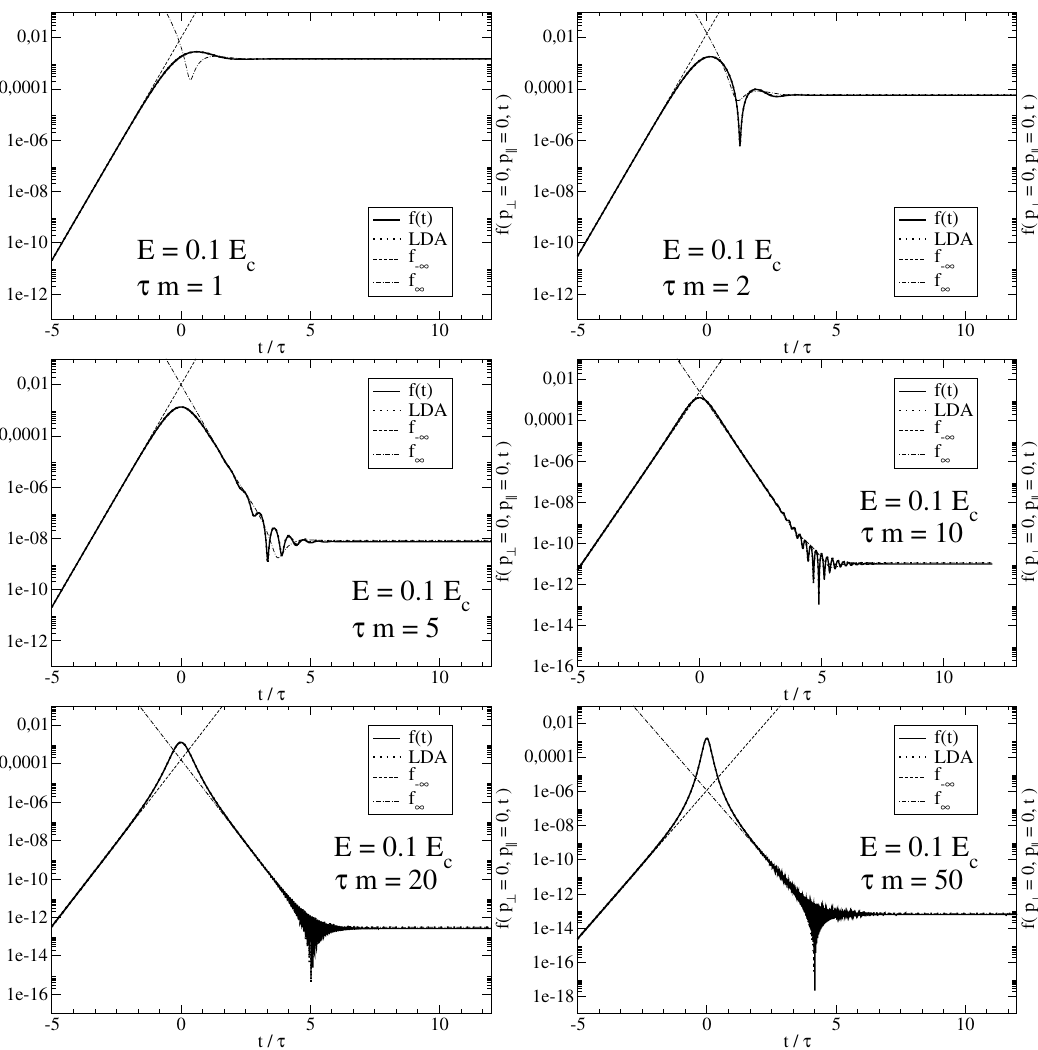
Figure 2. Time evolution of the fermionic distribution function f ( p ⊥ = 0, p (cid:107) = 0, t ) in the case of Sauter pulse for E 0 = 0.1 E c . From the upper left to the lower right panel the pulse duration increases as τ m = 1,2,5,10,20,50. The solid curve is for the full solution f ( t ) . The dotted curve shows the low density approximation, the dashed curve depicts the small-t asymptotics f − ∞ , while the dot-dashed curve stands for the large-t asymptotics f ∞